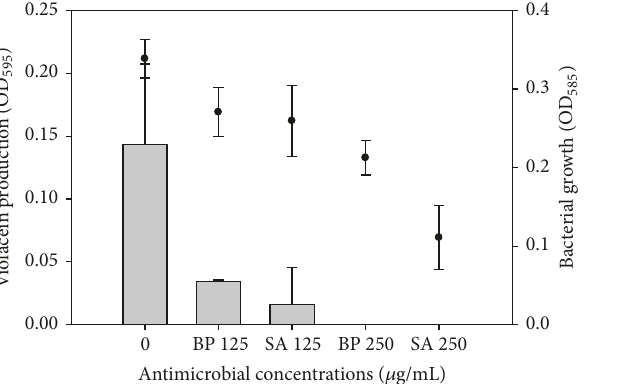
g/mL)SA Antimicrobial concentrations (  Figure 6: Effect of benzoyl peroxide (BP) and salicylic acid (SA) on violacein production and growth of C. violaceum. Violacein production (OD 595 ) (gray colour); bacterial growth (OD 585 ) ( e ).